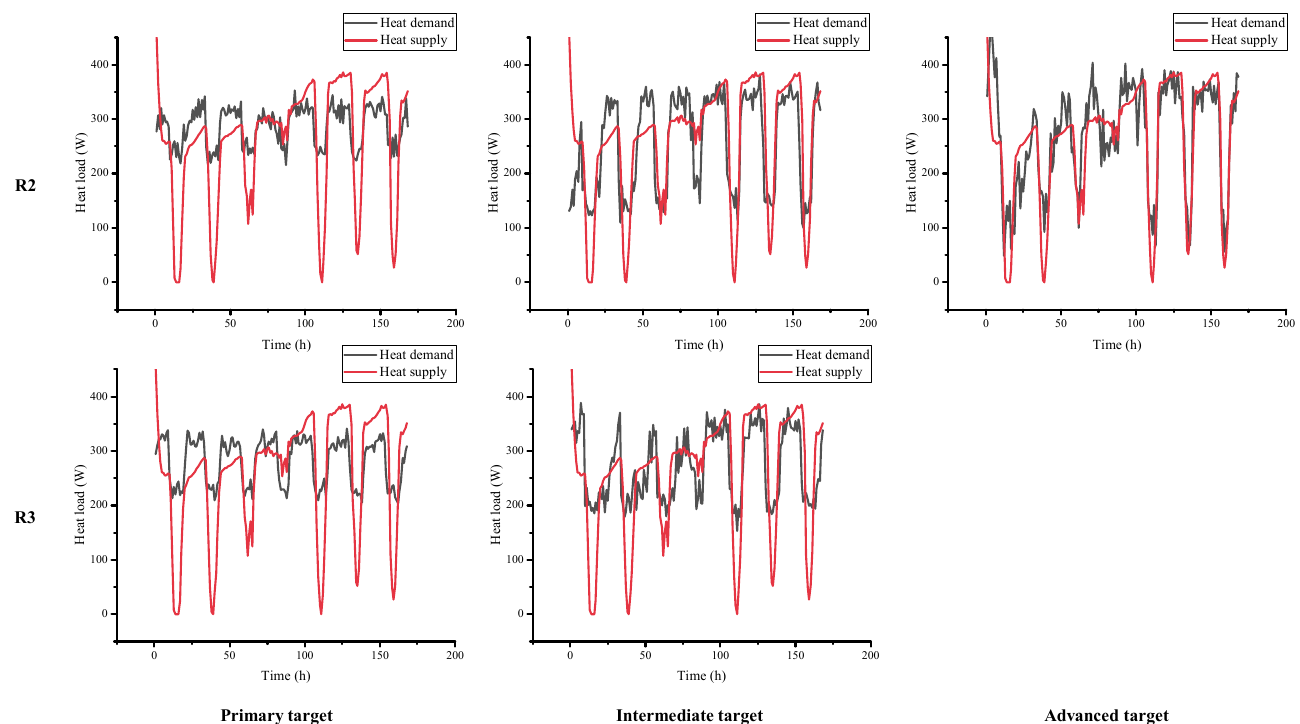
Figure 13. Results of heat supply controlled by different prediction models.